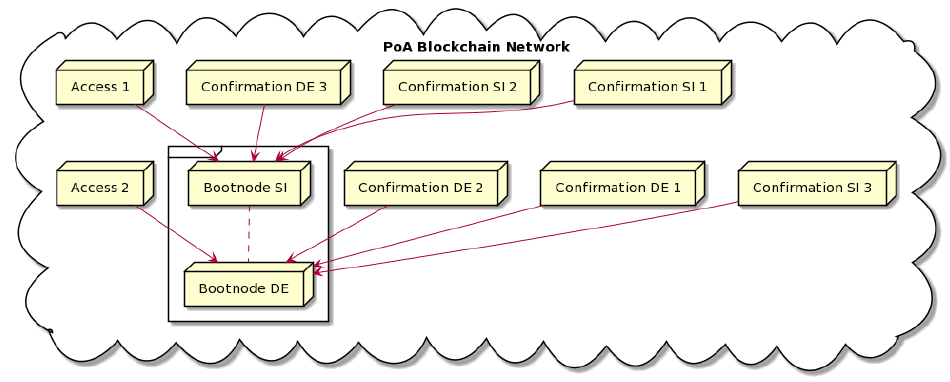
Figure 6. PoA network architecture.